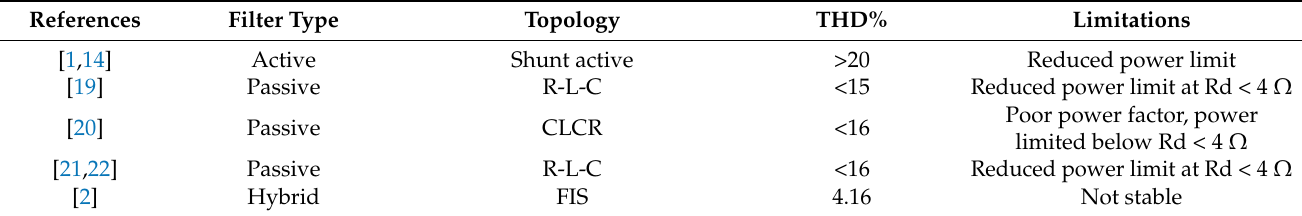
Table 1. Summary of reviewed